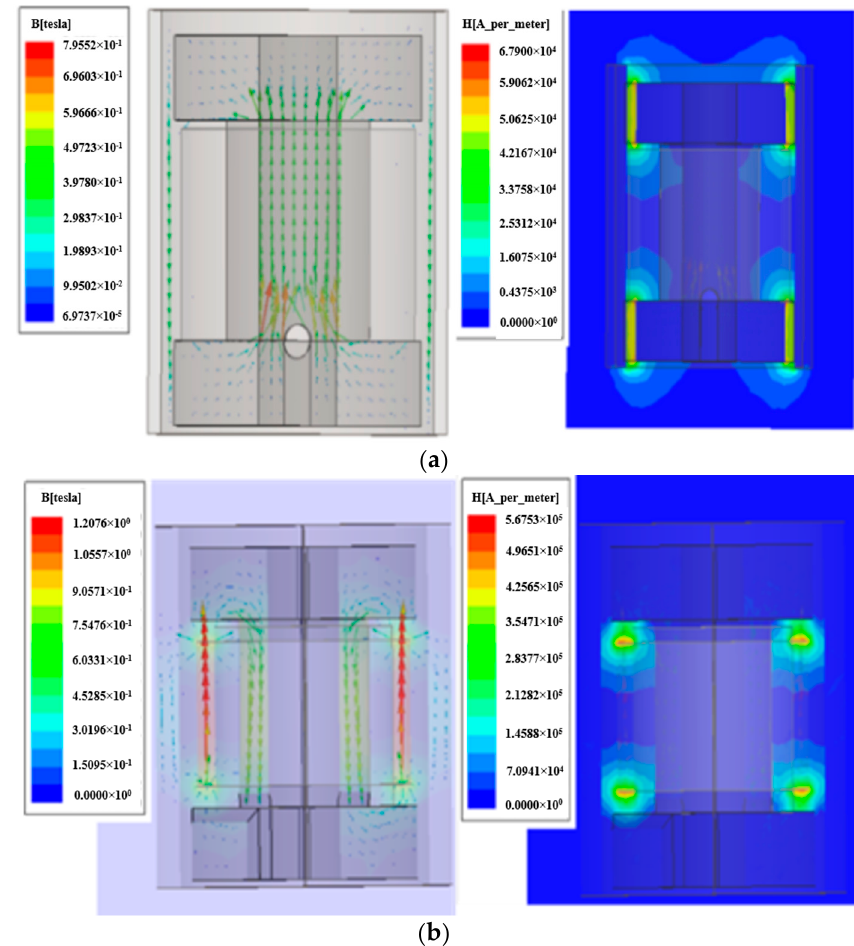
Figure 3. ( a ) The result without permanent magnets ( b ) the result with permanent